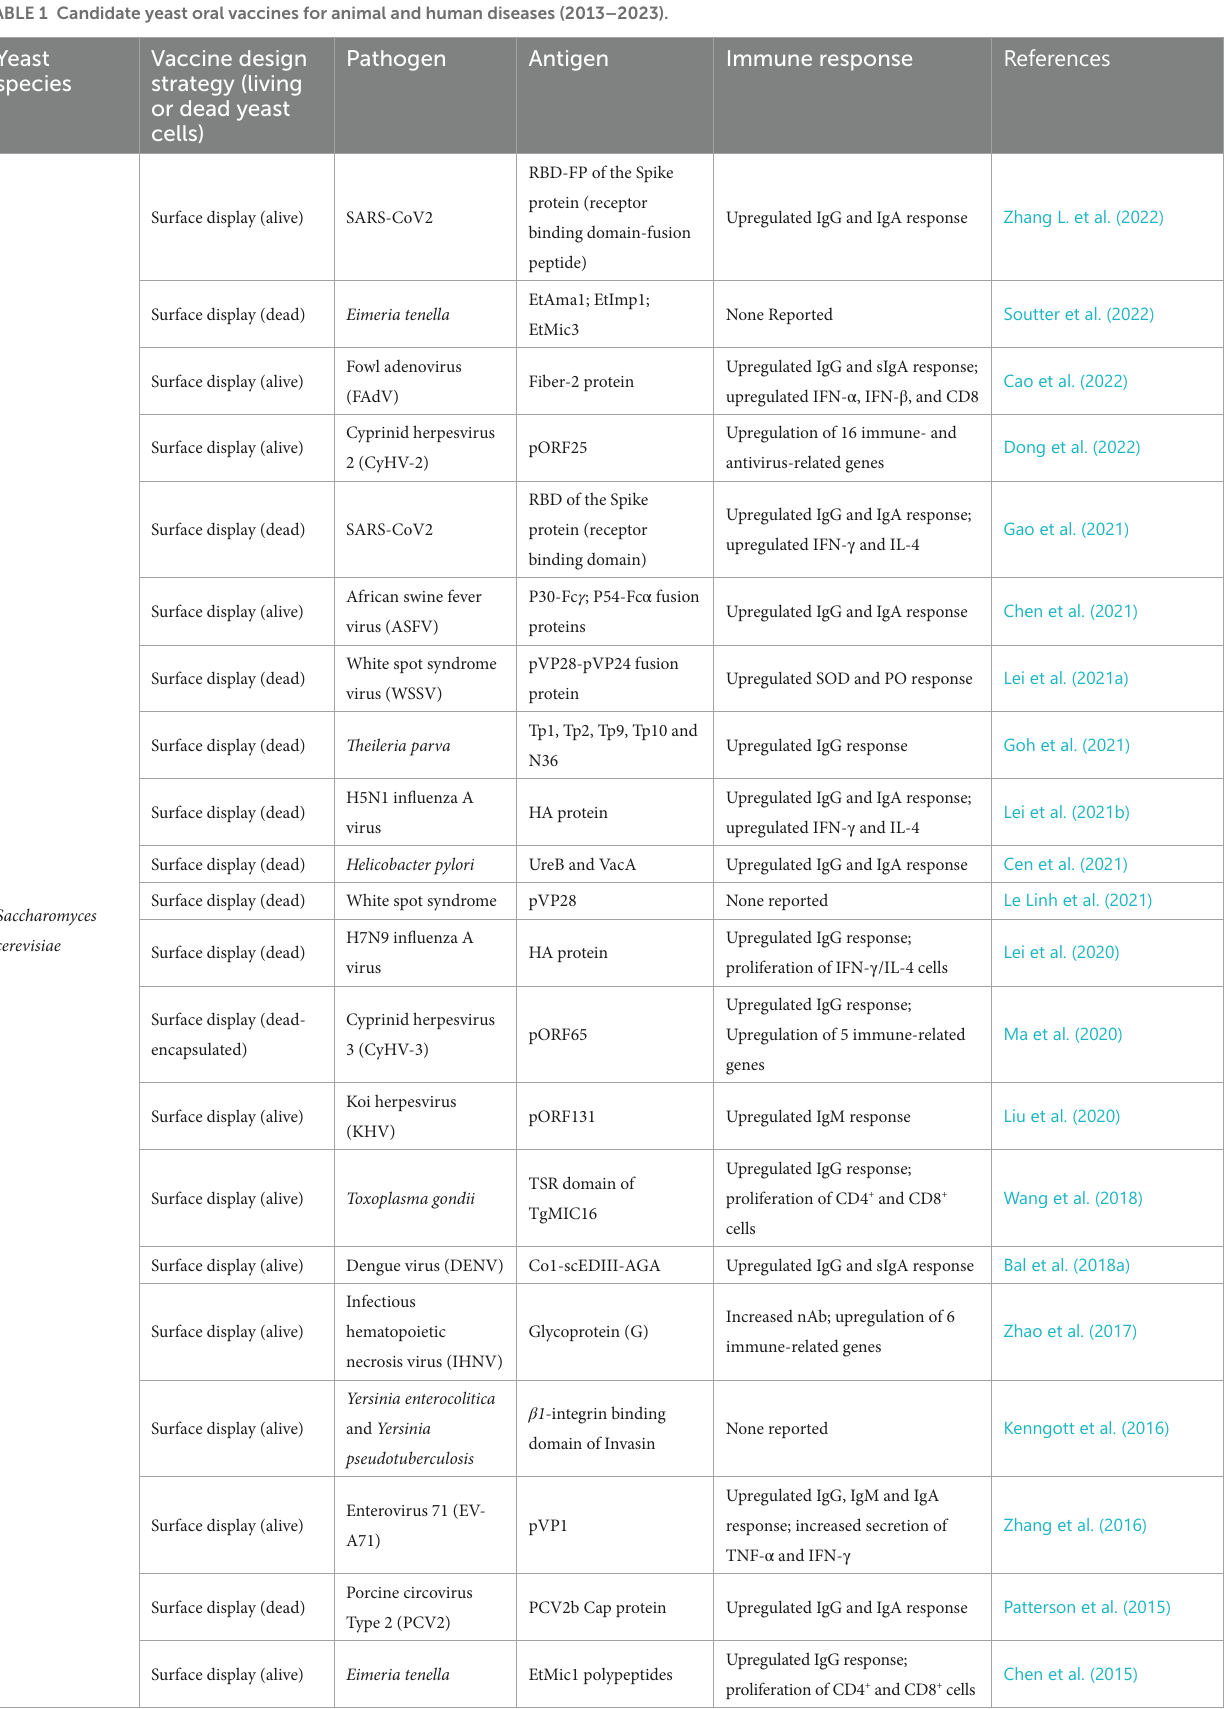
TABLE 1 Candidate yeast oral vaccines for animal and human diseases